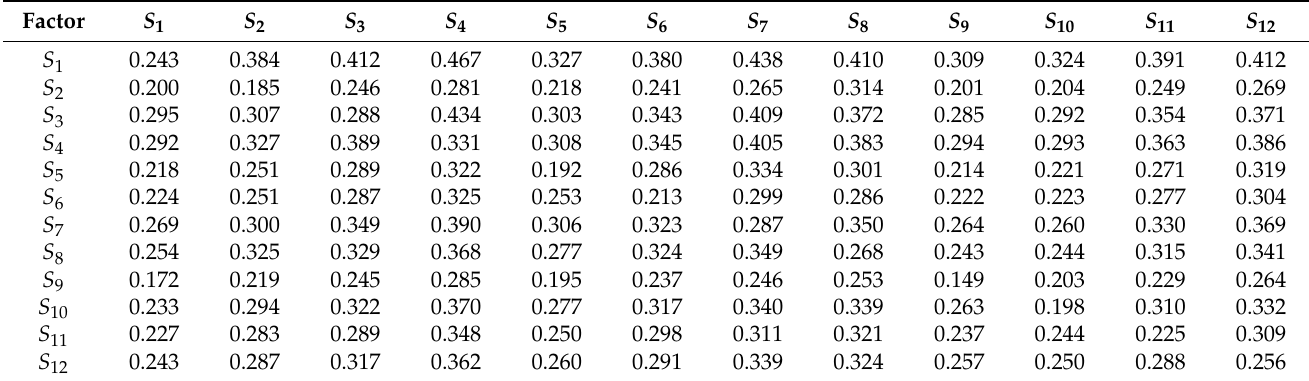
Table 4. Comprehensive influence matrix A for the influencing factors of job